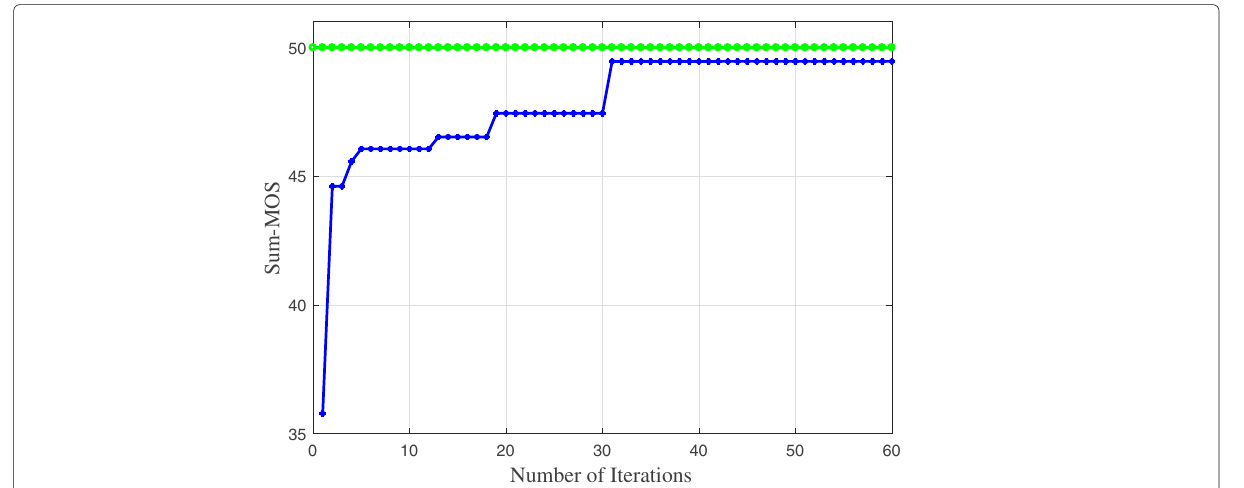
Fig. 6 The changing curve of sum-MOS as the number of iterations increases by preforming Algorithm